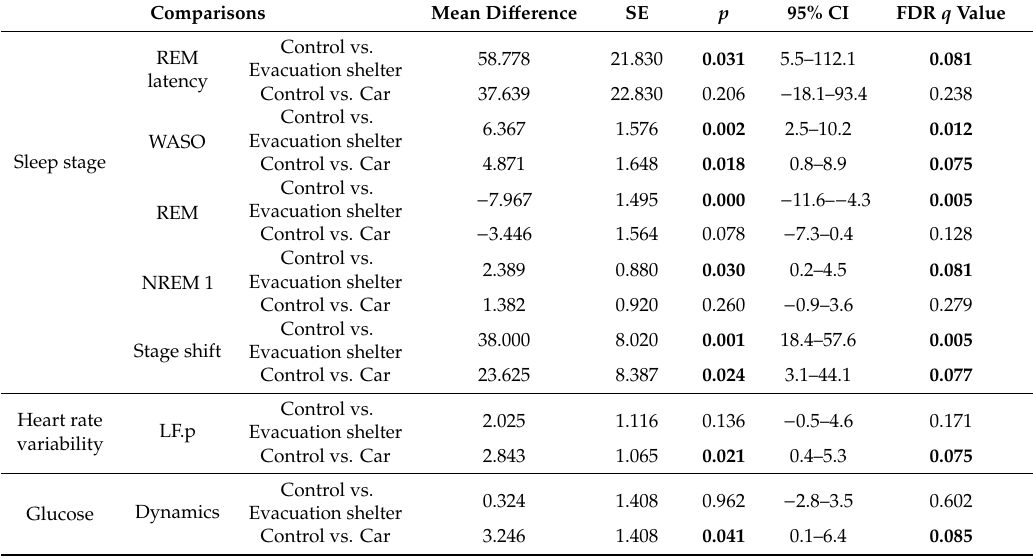
Table 2. Dunnett’s post hoc